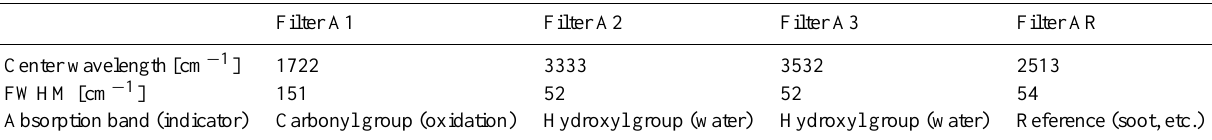
Table 1. Filter parameters of the band-pass filters for analysis of hydrocarbon-based oils, i.e., mineral and synthetic oils (filter combination A, hydrocarbon configuration).